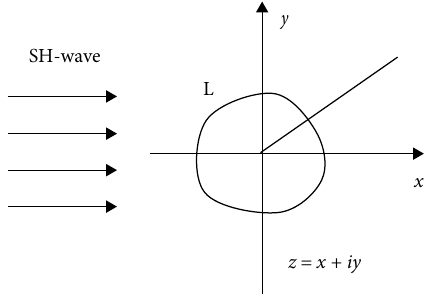
Figure 1: The scattering of SH-wave around an arbitrary shaped